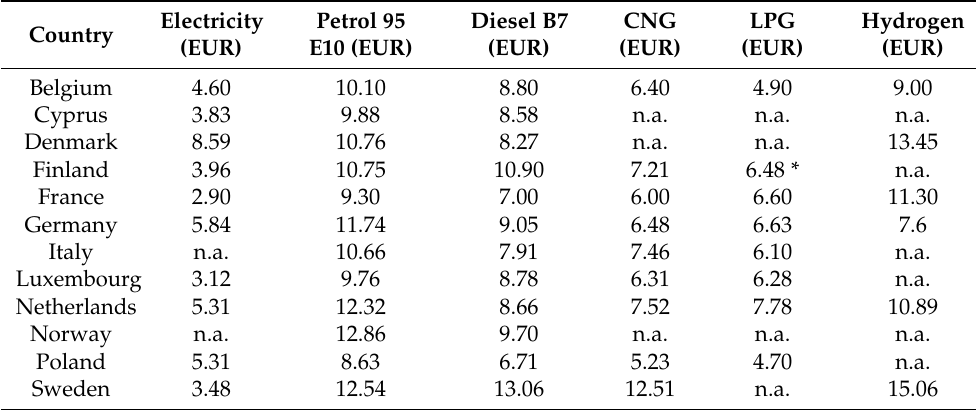
Table 1. Average cost of fuel per 100 km by selected European country (2022 1st quarter).